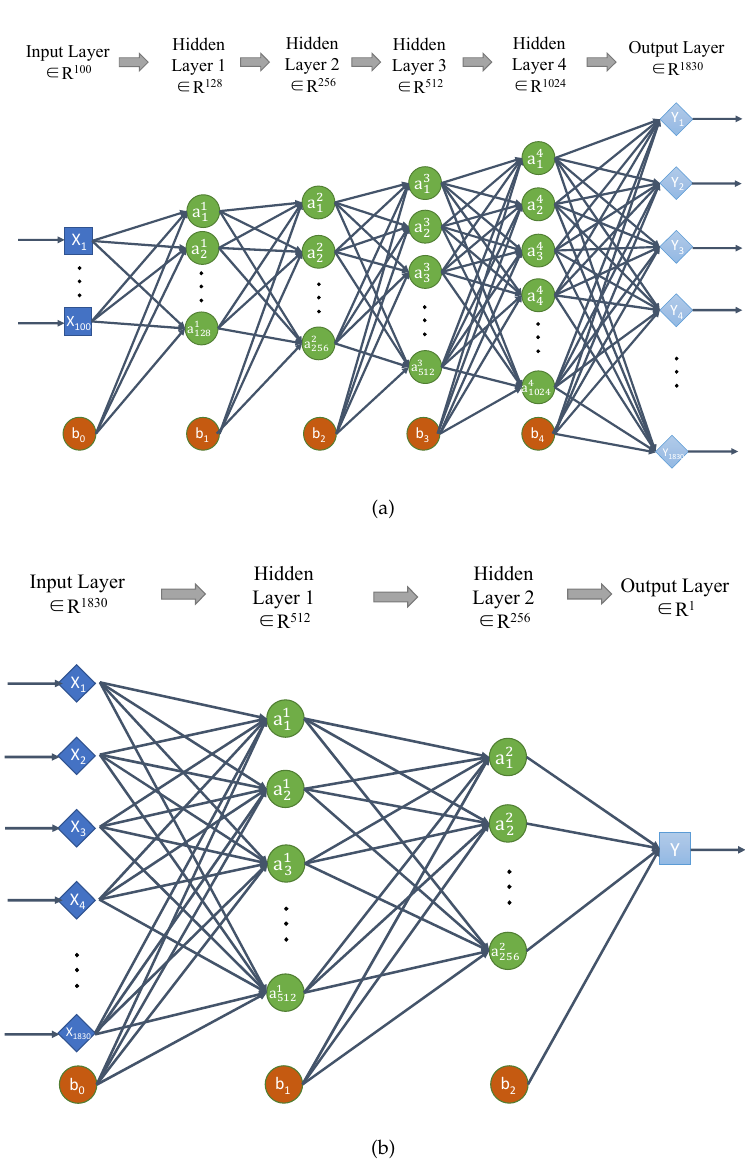
Figure 4. The network structure of Generative Adversarial Networks (GAN) (( a ) N tg and ( b ) N td ). For the improvement of all layers of GDANN, the LeakyRelu function was employed as the activation function, as shown in Equation (1), where leak ∈ ( 0, 1 ) is a constant. In this way, some negatives are retained, and the correspondingly effective information will not be completely lost.